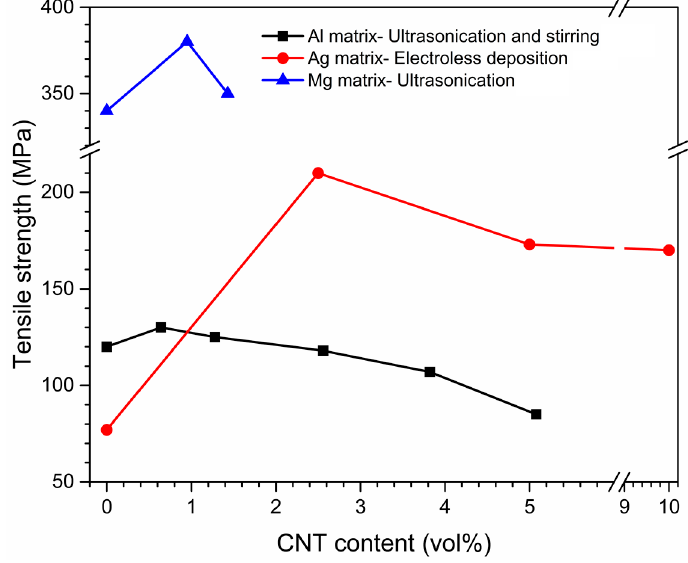
Figure 9. The tensile strength of some SPSed CNT-metal matrix nanocomposites fabricated by various dispersion methods [14,96,97].